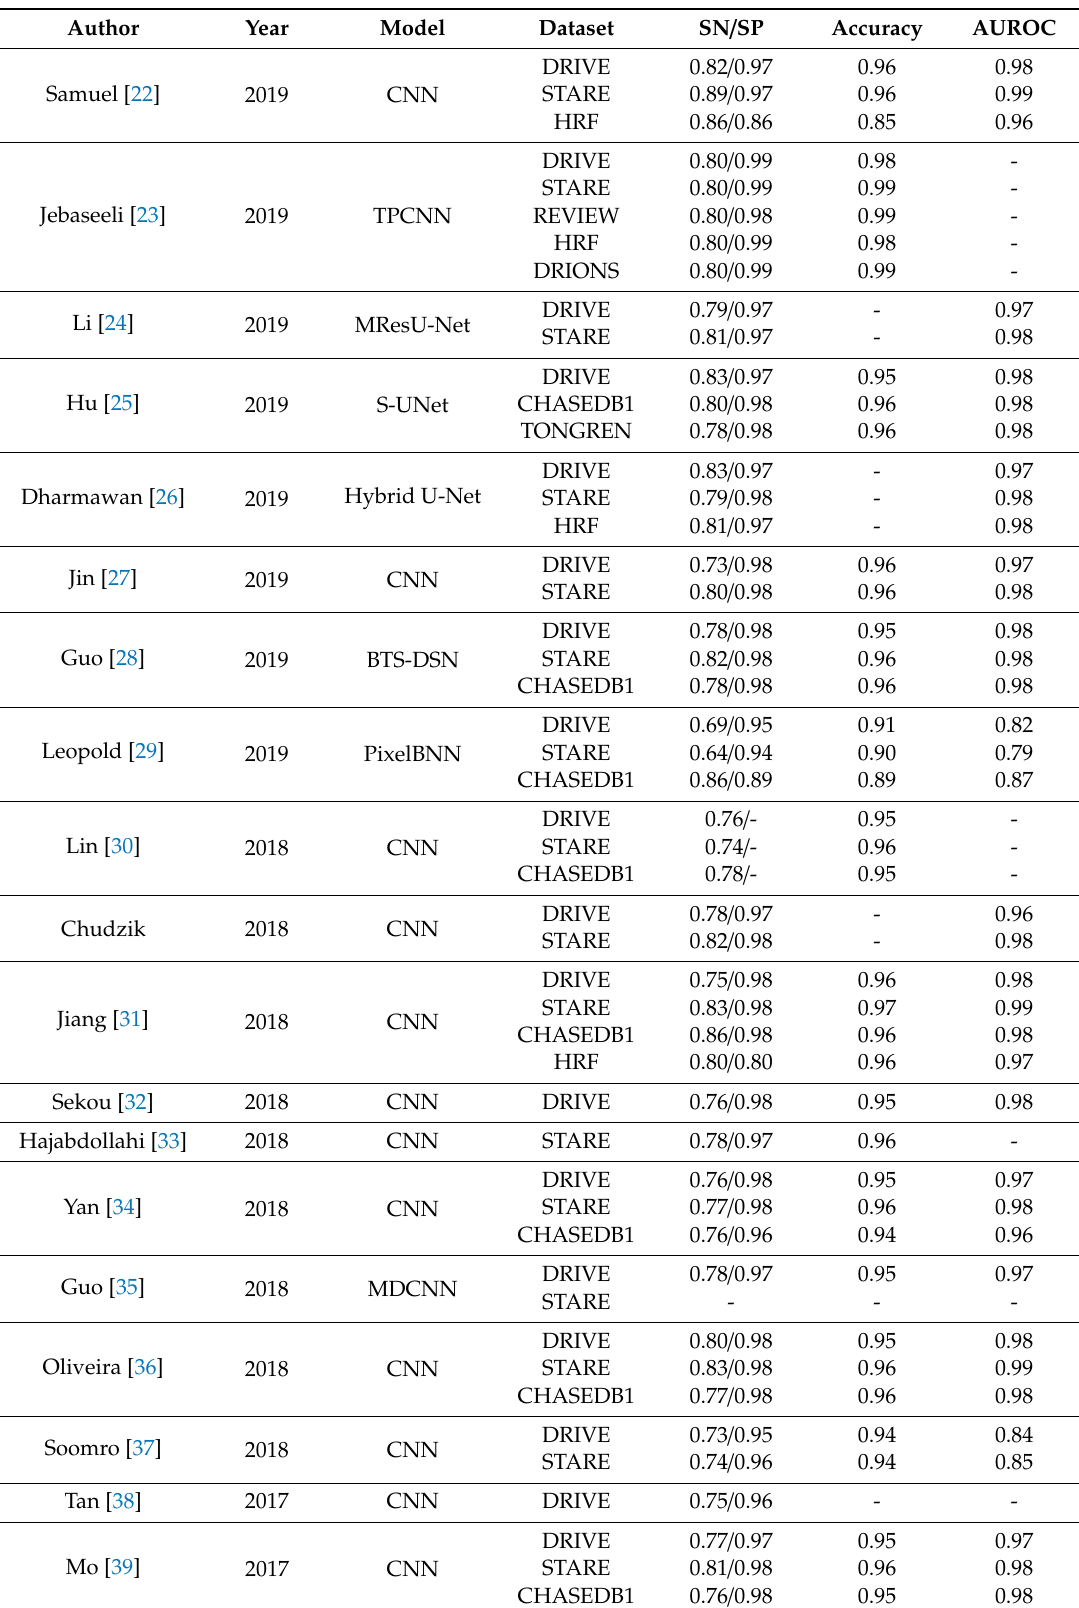
Table 1. Characteristic of included